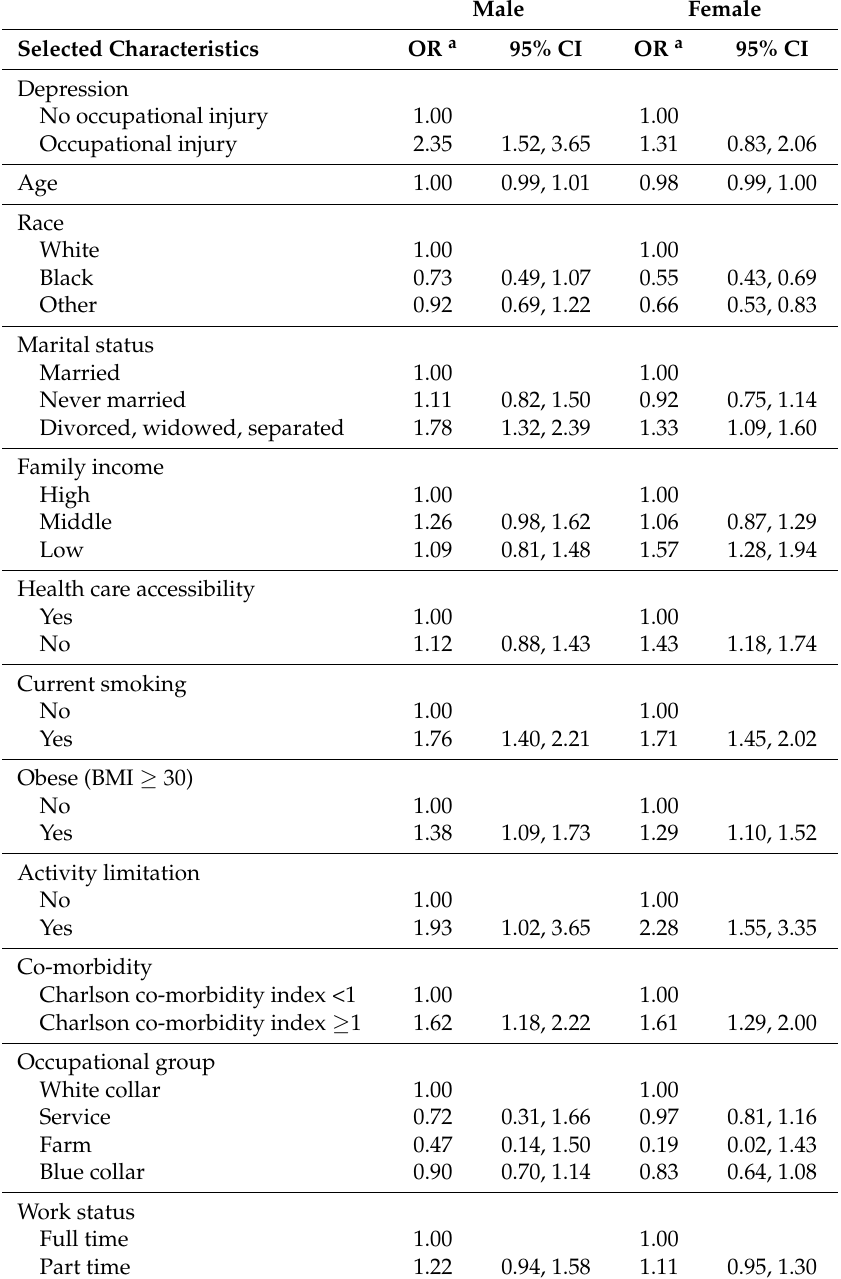
Table 2. Association between occupational injury and subsequent depression in the MEPS population. Male